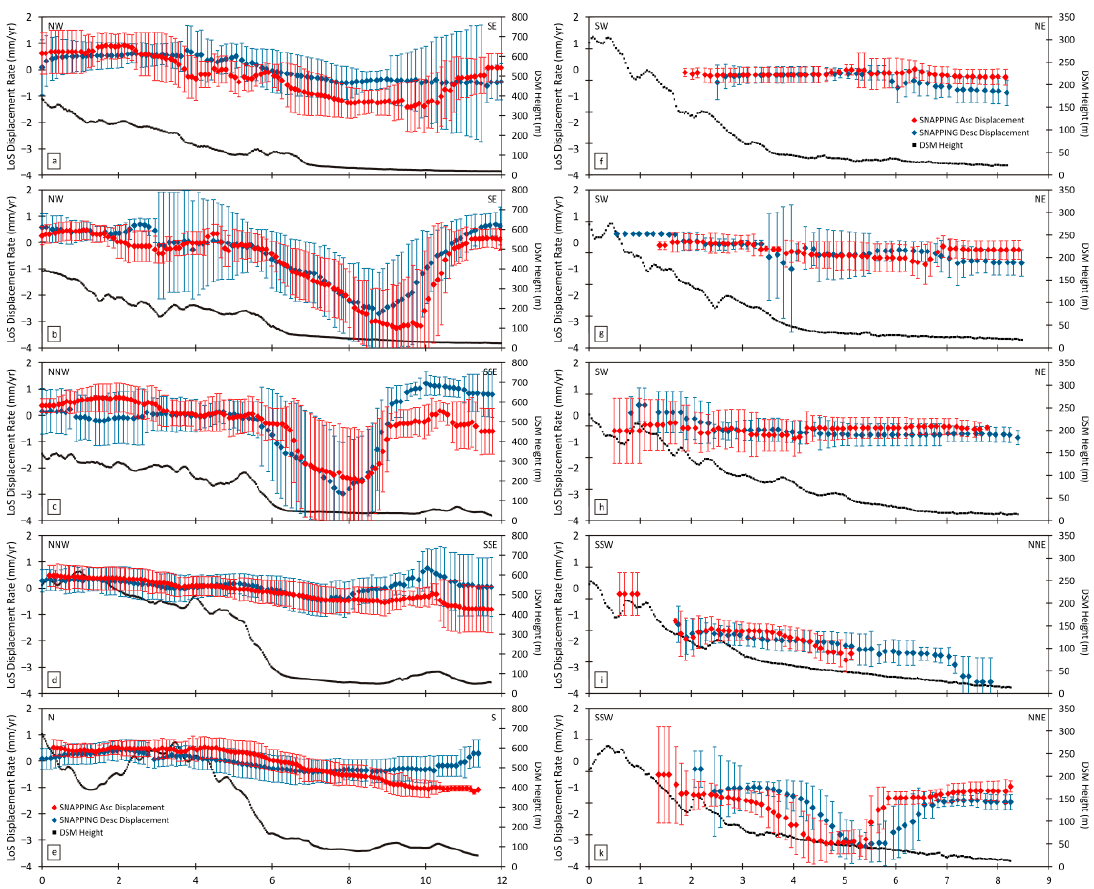
Figure 11. Spatial profiles ( a – e and f – k ) showing LoS displacement rates across major fault zones from both ascending and descending satellite tracks (see Figures 6 and 7). For the calculations, average motion grids of 100 m spacing were used. Bars indicate the variability of motion within a buffer of 1–2 km, whereas dots the average calculated rates along the profiles.